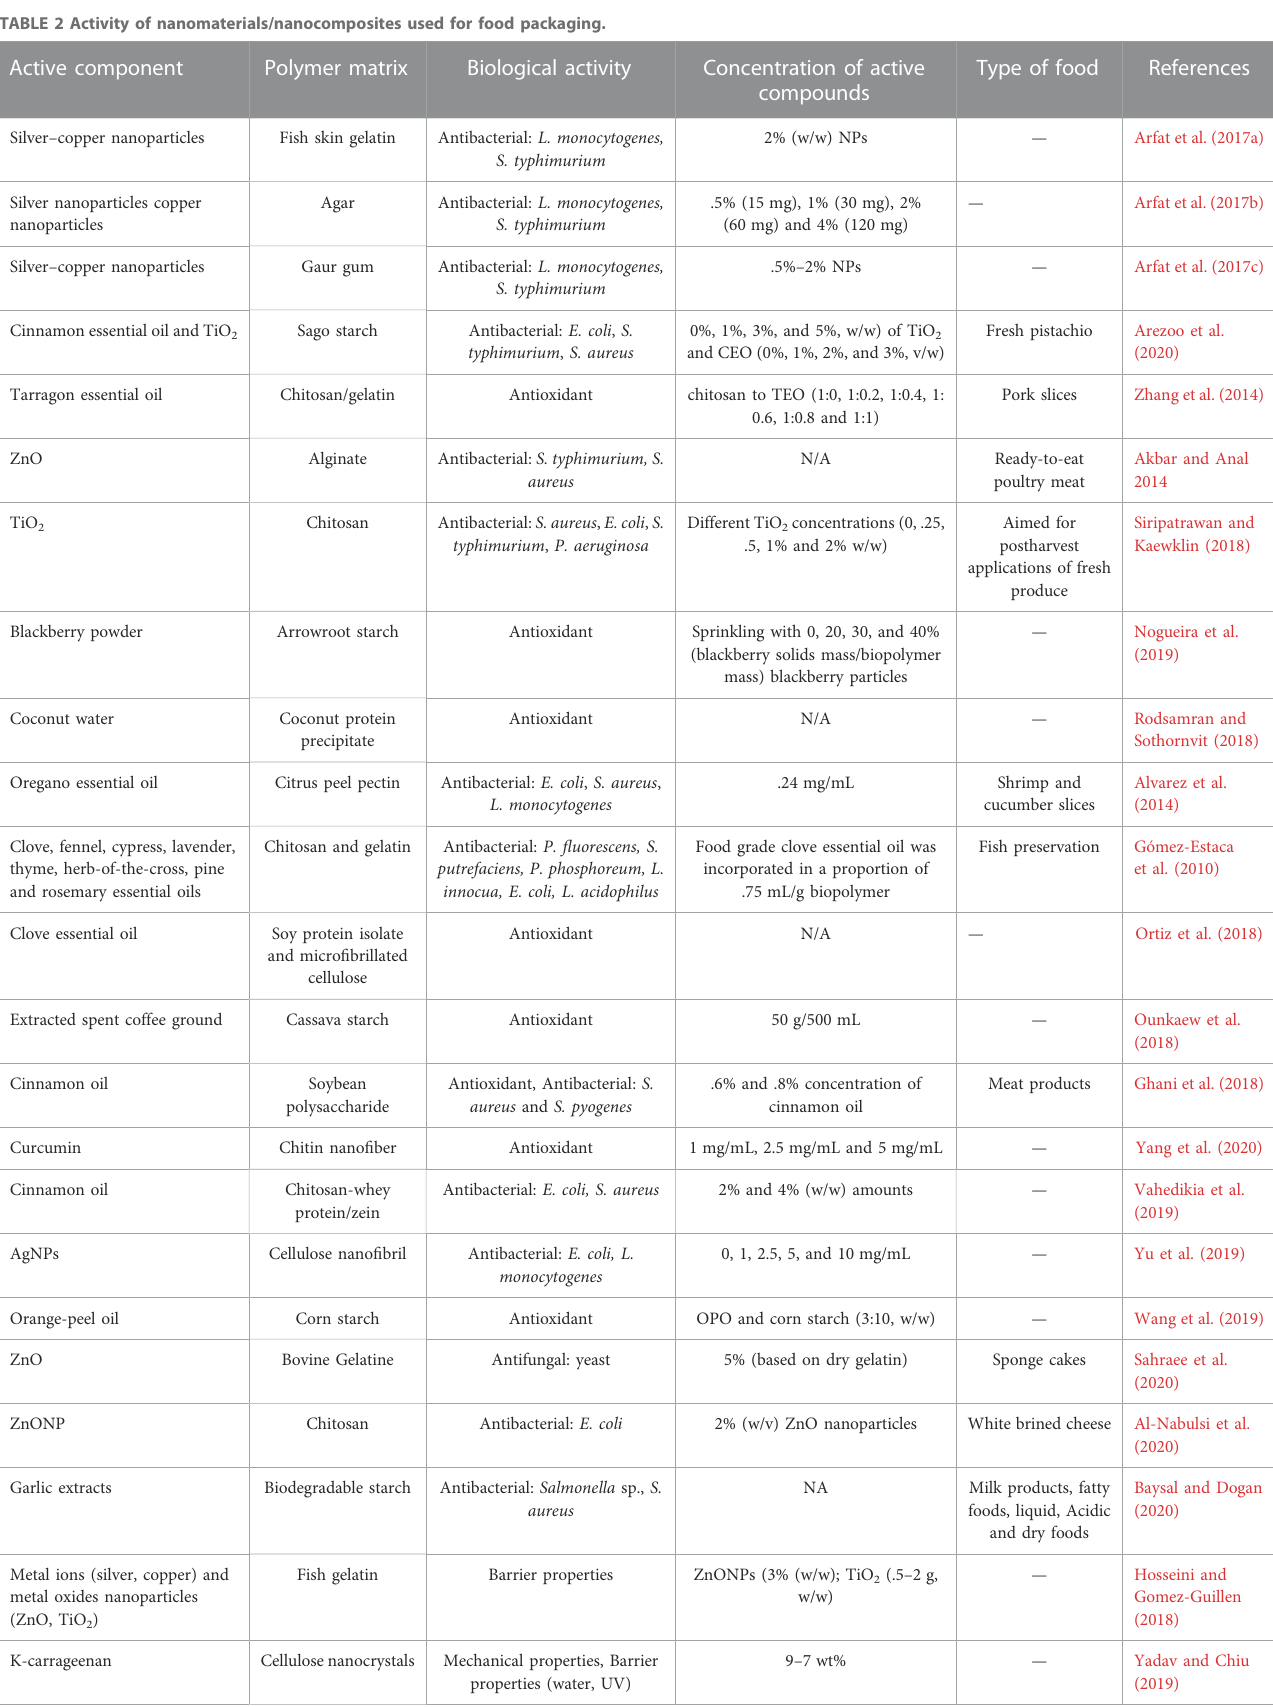
TABLE 2 Activity of nanomaterials/nanocomposites used for food